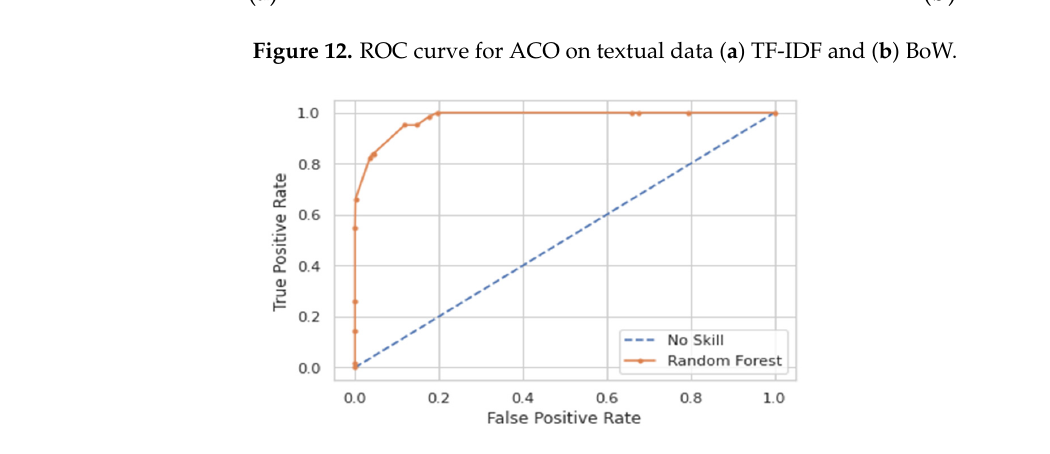
Figure 13. ROC curve for a numerical dataset with ACO. Table 5. Performance comparison of best models for textual and numerical dataset.